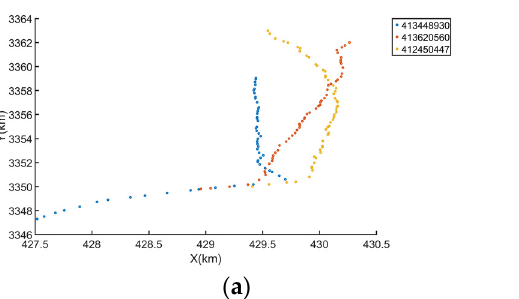
Figure 9. The multi-ship encounter situation.